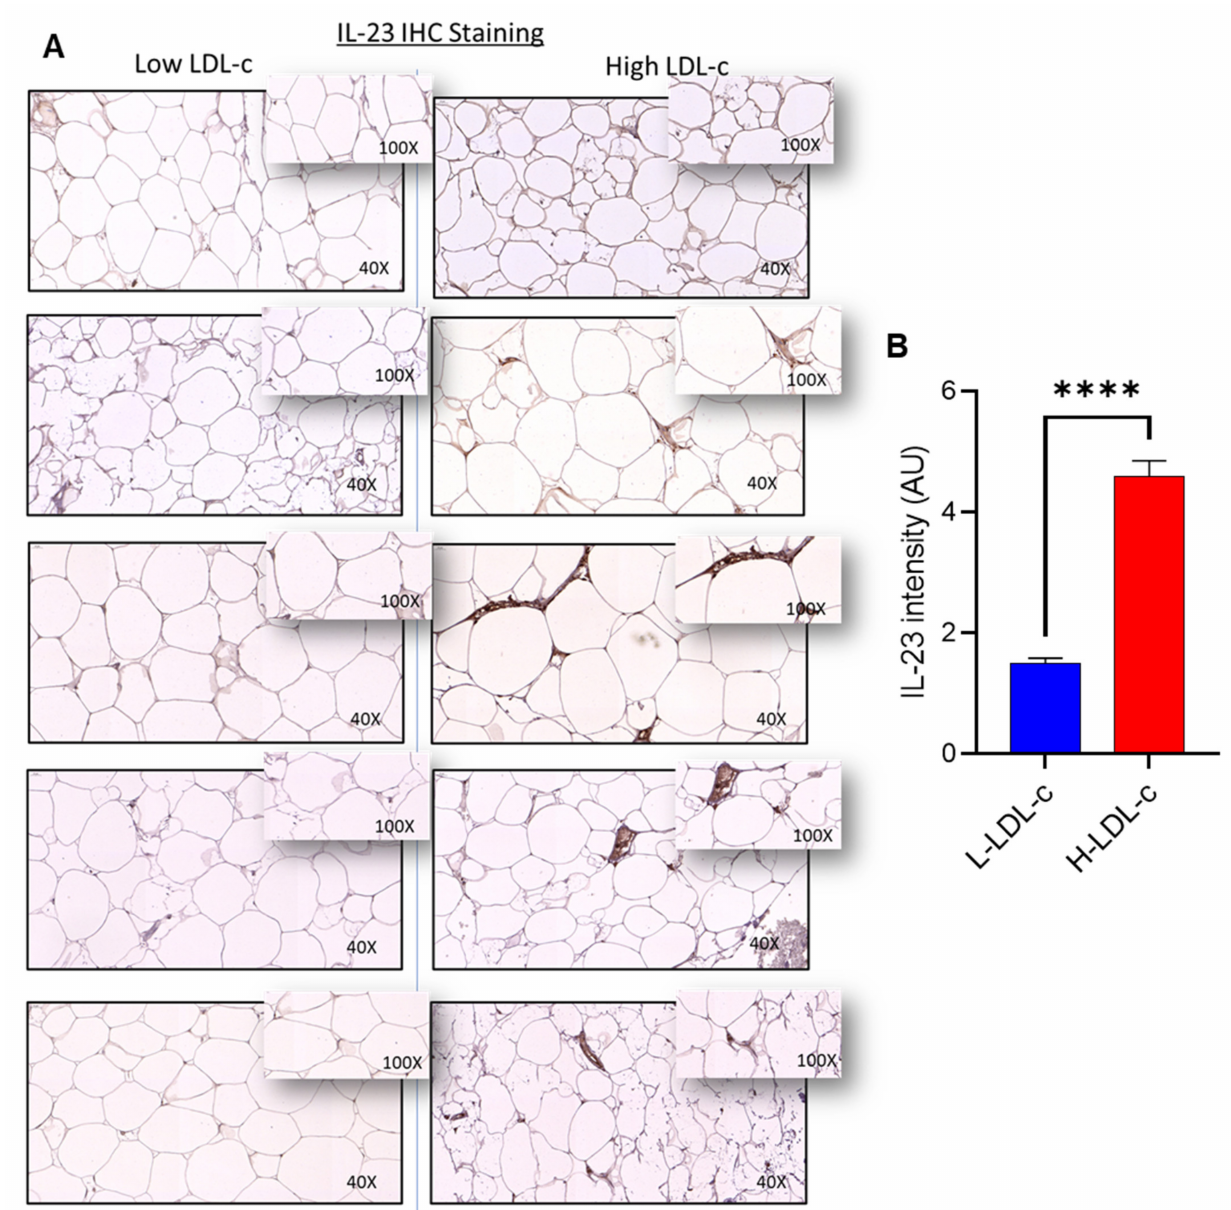
Figure 2. Increased adipose tissue IL-23 protein expression in people with high LDL-c. IL-23 protein expression was assessed in people with low LDL-c (L-LDL-c) and high LDL-c (H-LDL-c) levels, 5 each, using IHC, as described in “Materials and methods”. ( A ) The representative IHC images obtained from three independent determinations show the elevated adipose tissue expression of IL-23 protein (40 × or insert 100 × magnification) in people with H-LDL-c ( ≥ 2.9 mmol/L) compared to those with L-LDL-c (<2.9 mmol/L). ( B ) Increased IL-23 protein expression is shown in H-LDL-c group compared to L-LDL-c group ( p < 0.0001). Staining intensity is expressed as arbitrary units (AU), determined based on Aperio-positive pixel counts (Aperio software algorithm version 9.0). IL-23 protein expression data are presented as mean ± SEM values. All p -values < 0.05 were considered statistically significant. **** Represent highly